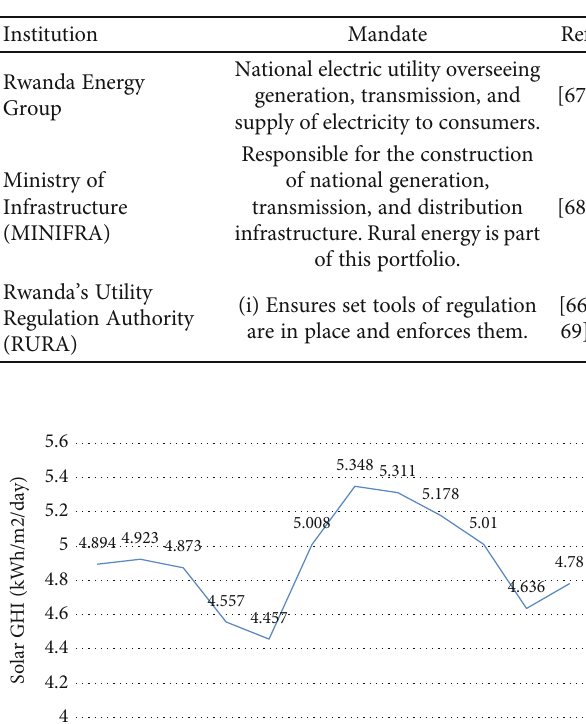
Table 24: Institutions involved in the energy sector in Rwanda.